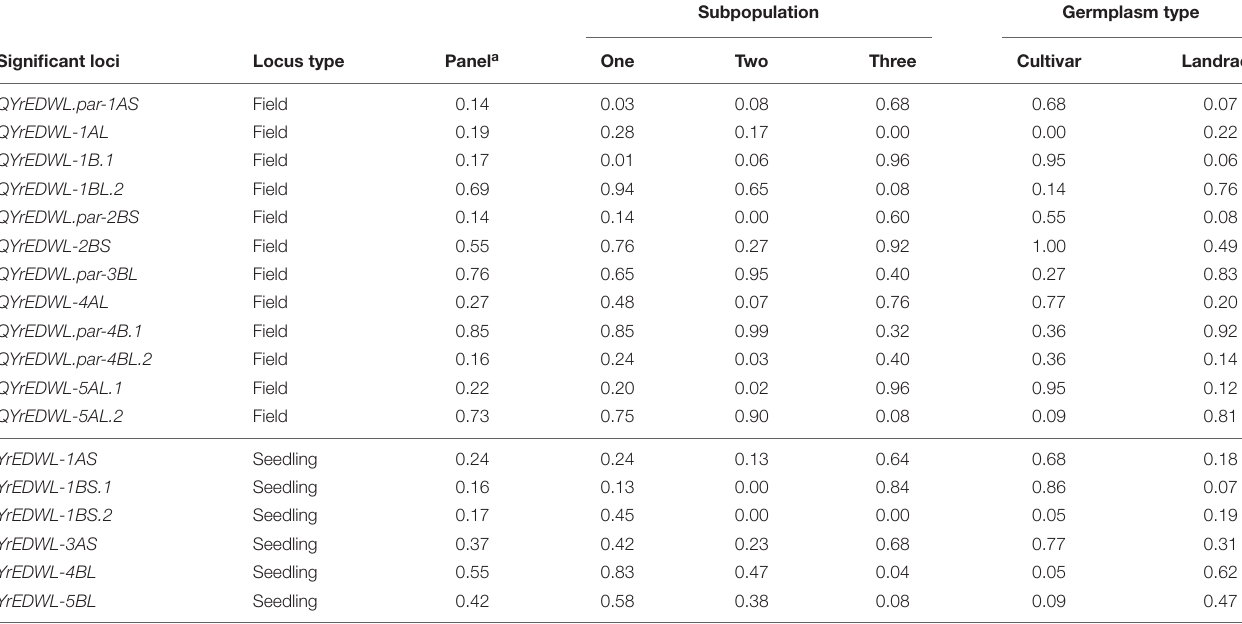
Subpopulation Germplasm type